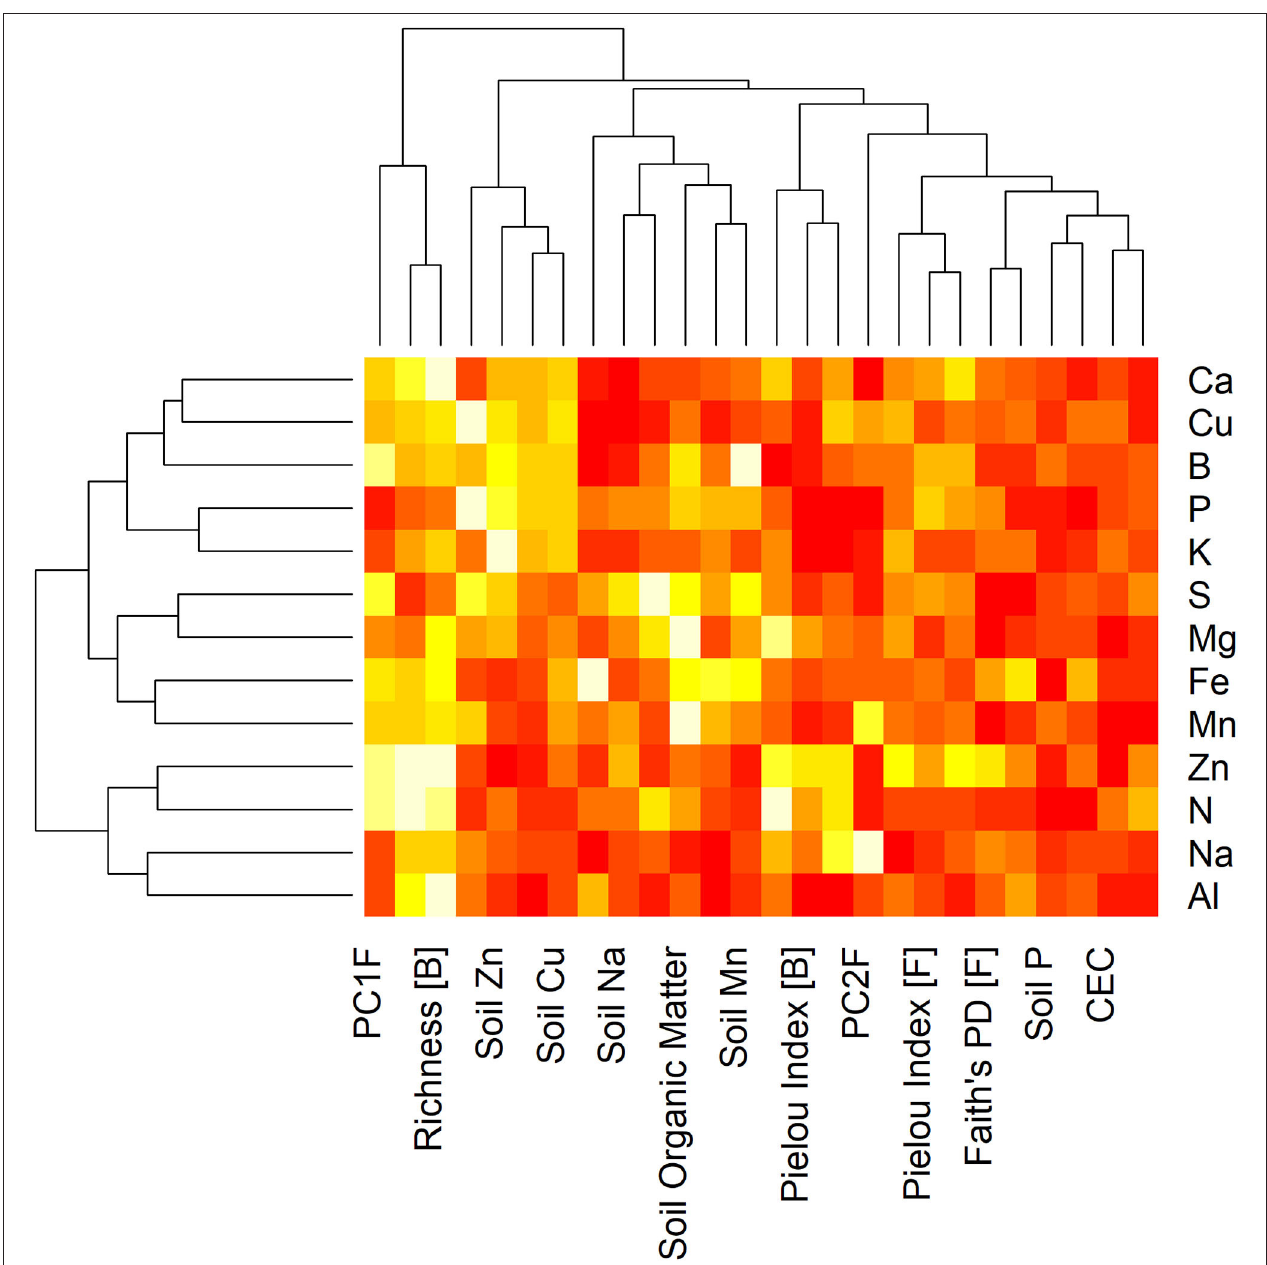
FIGURE 4 | Variable importance heatmap and dendrograms for leaf nutrient models. Stepwise regression analysis identified linear models with the combination of soil physicochemical properties and microbial diversity and composition metrics that best explained the concentrations of each leaf nutrient individually. The heatmap portrays the relative importance of each explanatory variable (columns) in each linear model (rows by response variable). Hierarchical clustering dendrograms along the “x” and “y” axes show similarity among variables and models, respectively. PC1B, PC2B: first and second principal components of bacterial community; PC1F, PC2F: first and second principal components of fungal community; CEC: cation exchange capacity; [B]: bacteria; [F]: